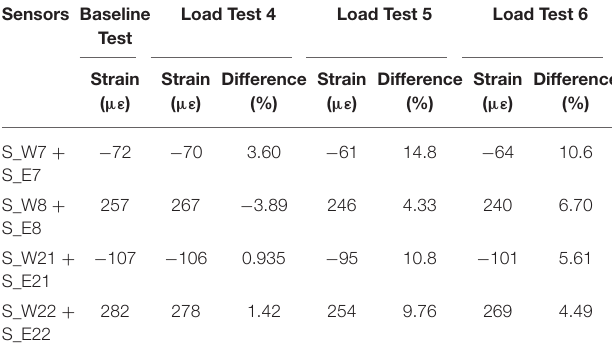
TABLE 7 | Comparison of baseline summation of peak top and bottom girder strains at midspan and the controlling location to summation of peak top and bottom girder strains from load tests 4, 5, and 6 for six truck